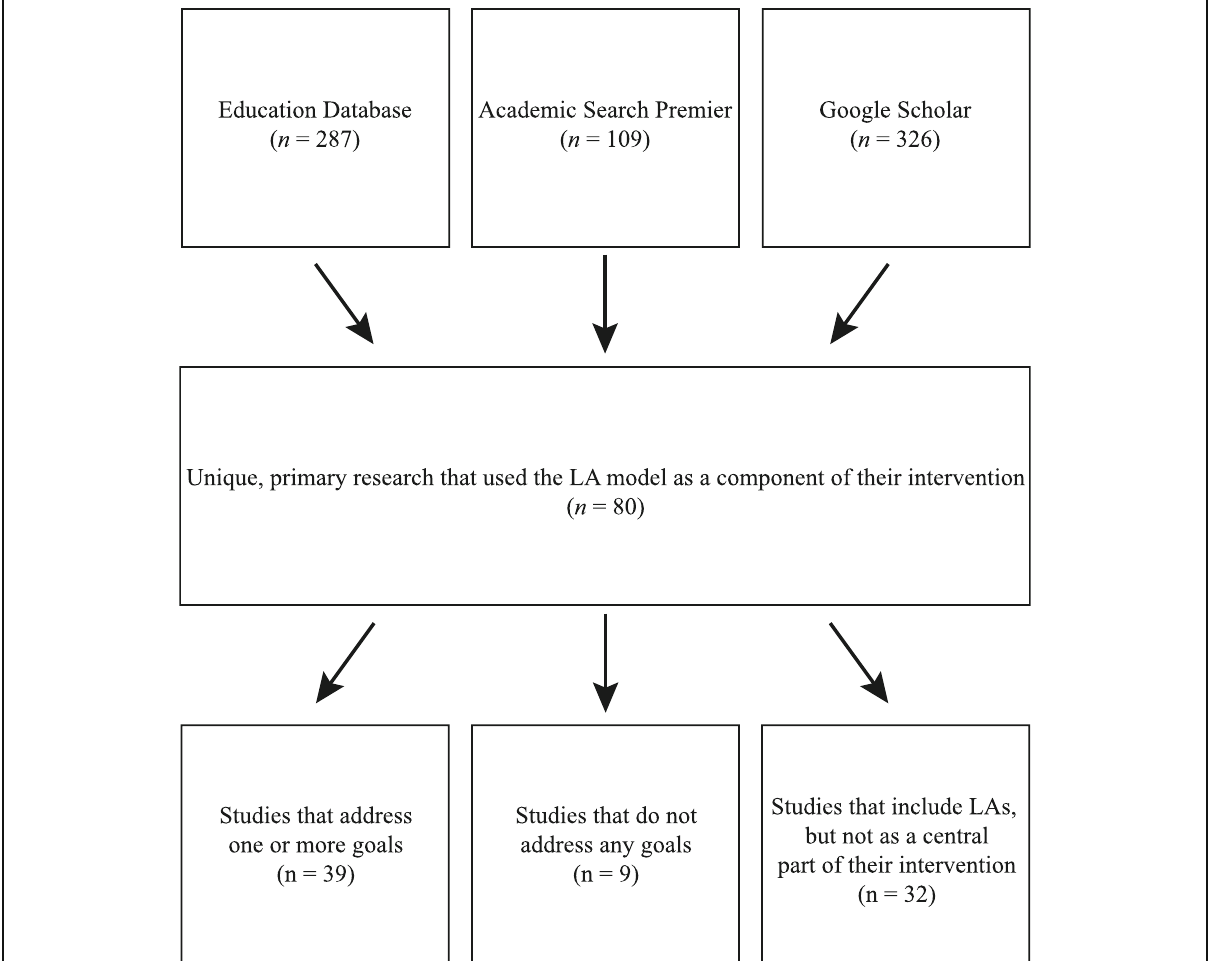
Fig. 2 Flow diagram of article selection and inclusion